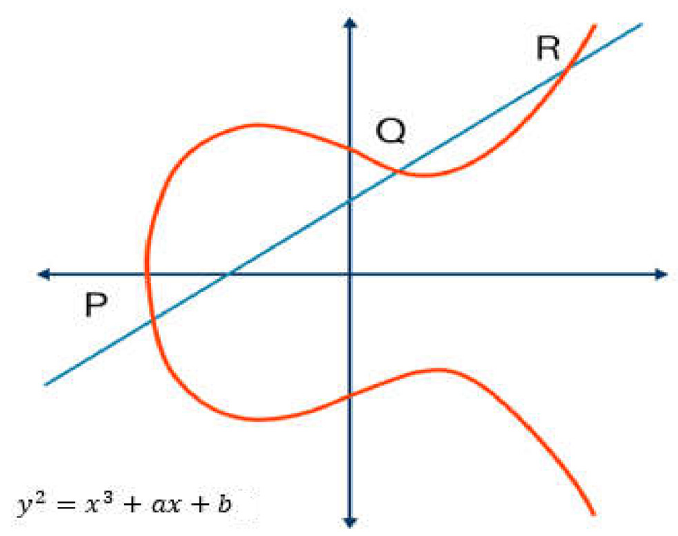
Figure 5. Elliptical curves over finite fields.